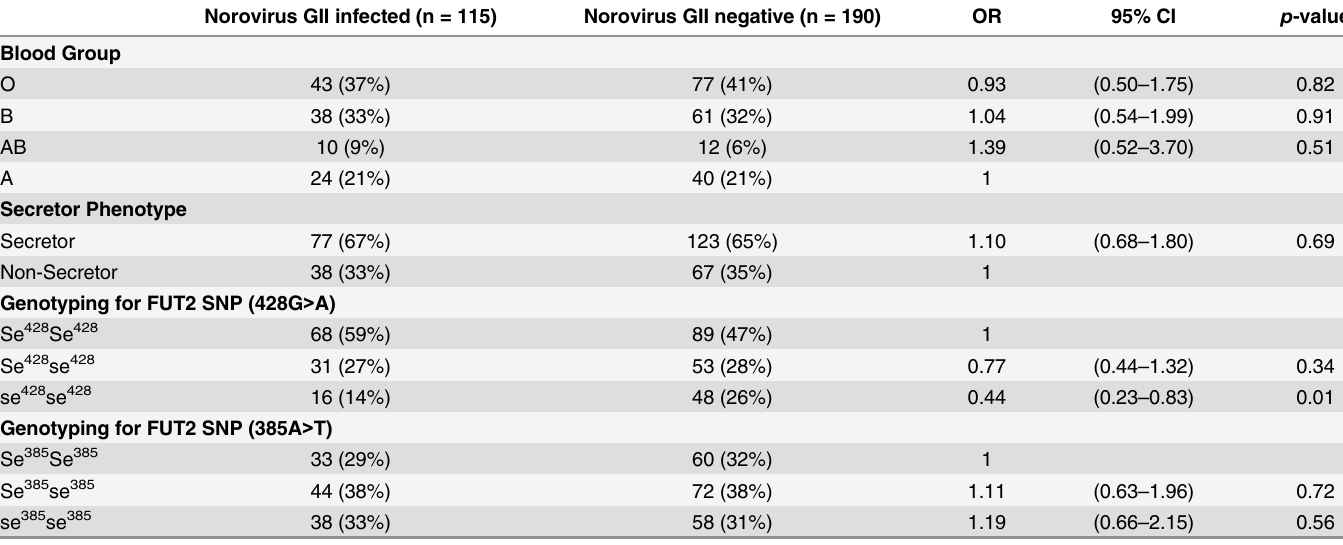
Table 5. Distribution of Histo-Blood Group and Secretor status among norovirus GII infected and non-infected individuals. Norovirus GII infected (n = 115) Norovirus GII negative (n =